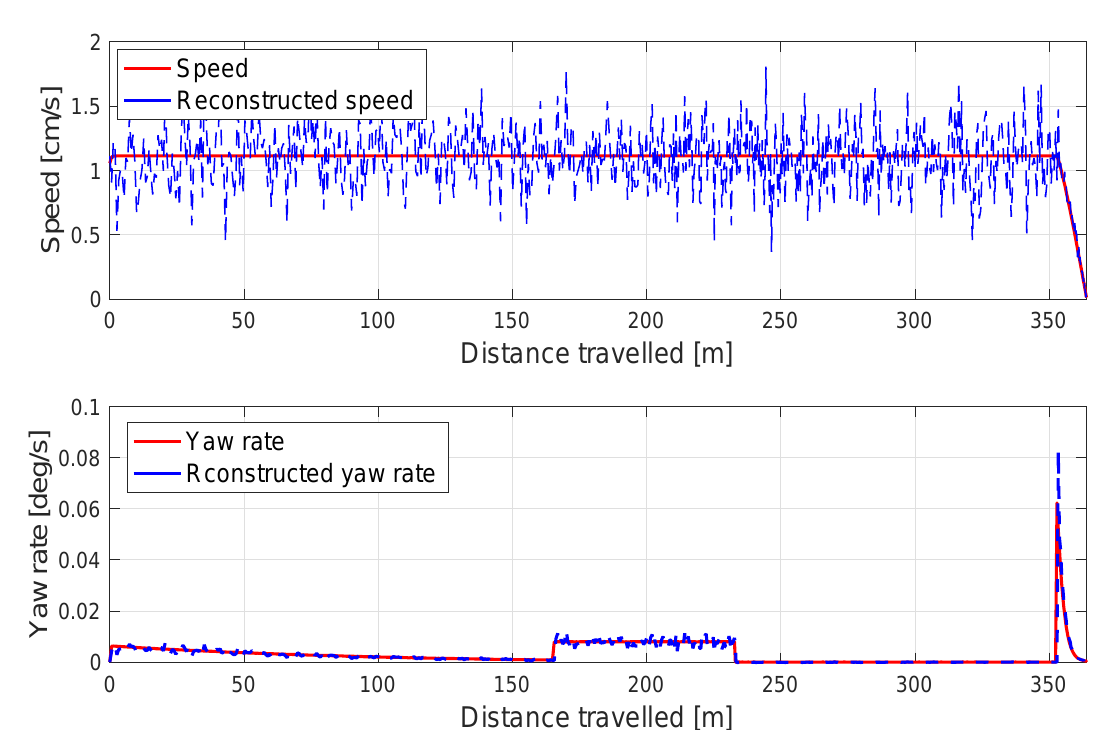
Figure 15. Slope angle used in the slip prediction method.